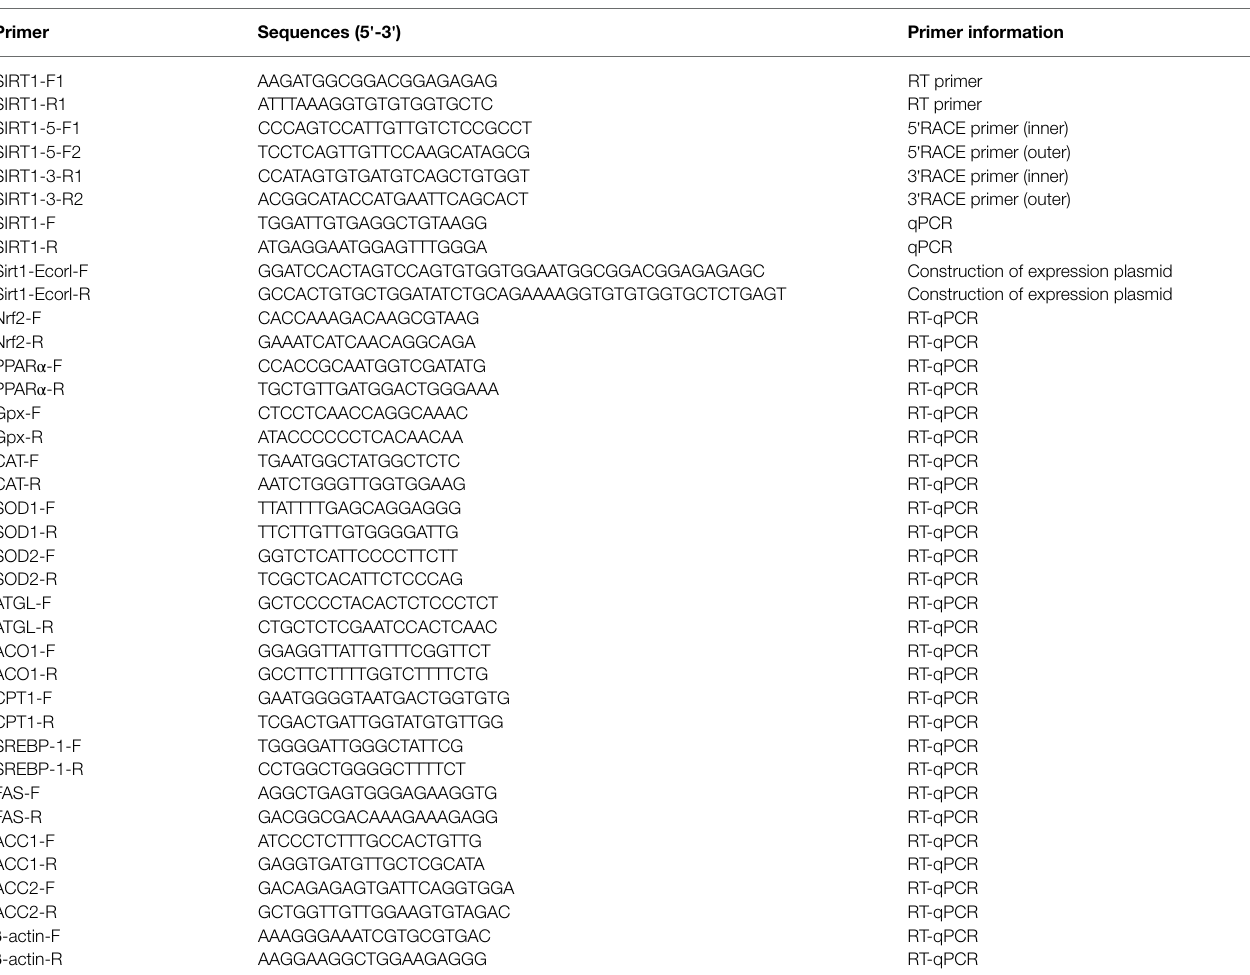
TABLE 1 | Sequences of the primers used in this